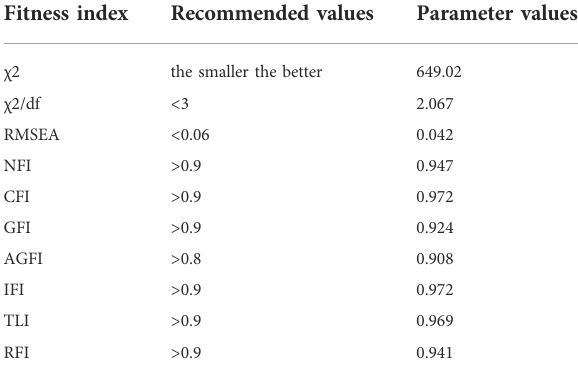
TABLE 4 Structural equation model fi t index value.